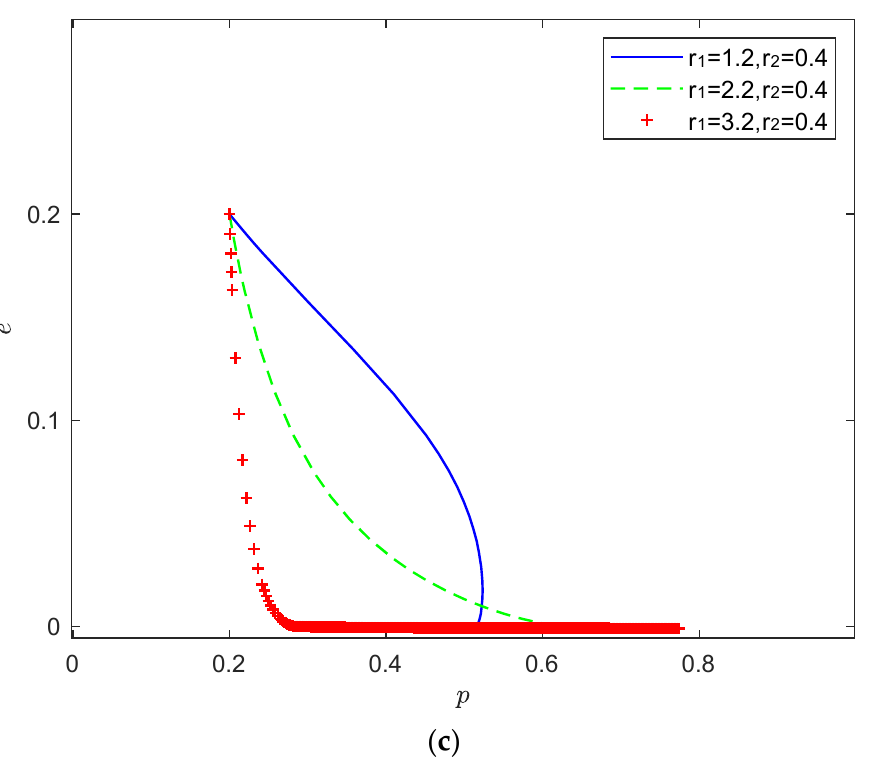
Figure 7. Evolution of game strategy in (pessimistic, optimistic) state. ( a ) Scenario 1, ( b ) Scenario 2, ( c ) Scenario 3.